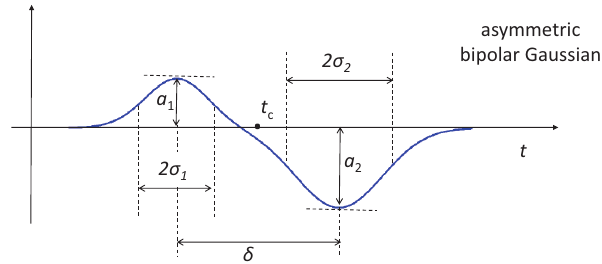
Figure 3. Asymmetric bipolar Gaussian template fitted to the differential current traces recorded when using the proposed wiring